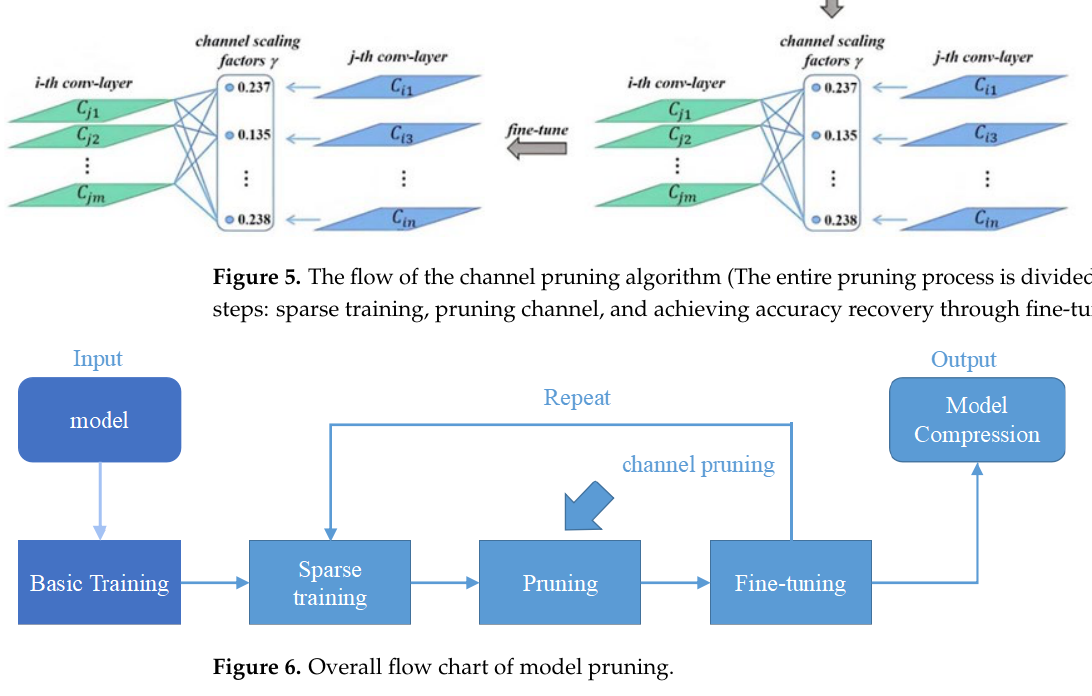
Figure 6. Overall flow chart of model pruning.